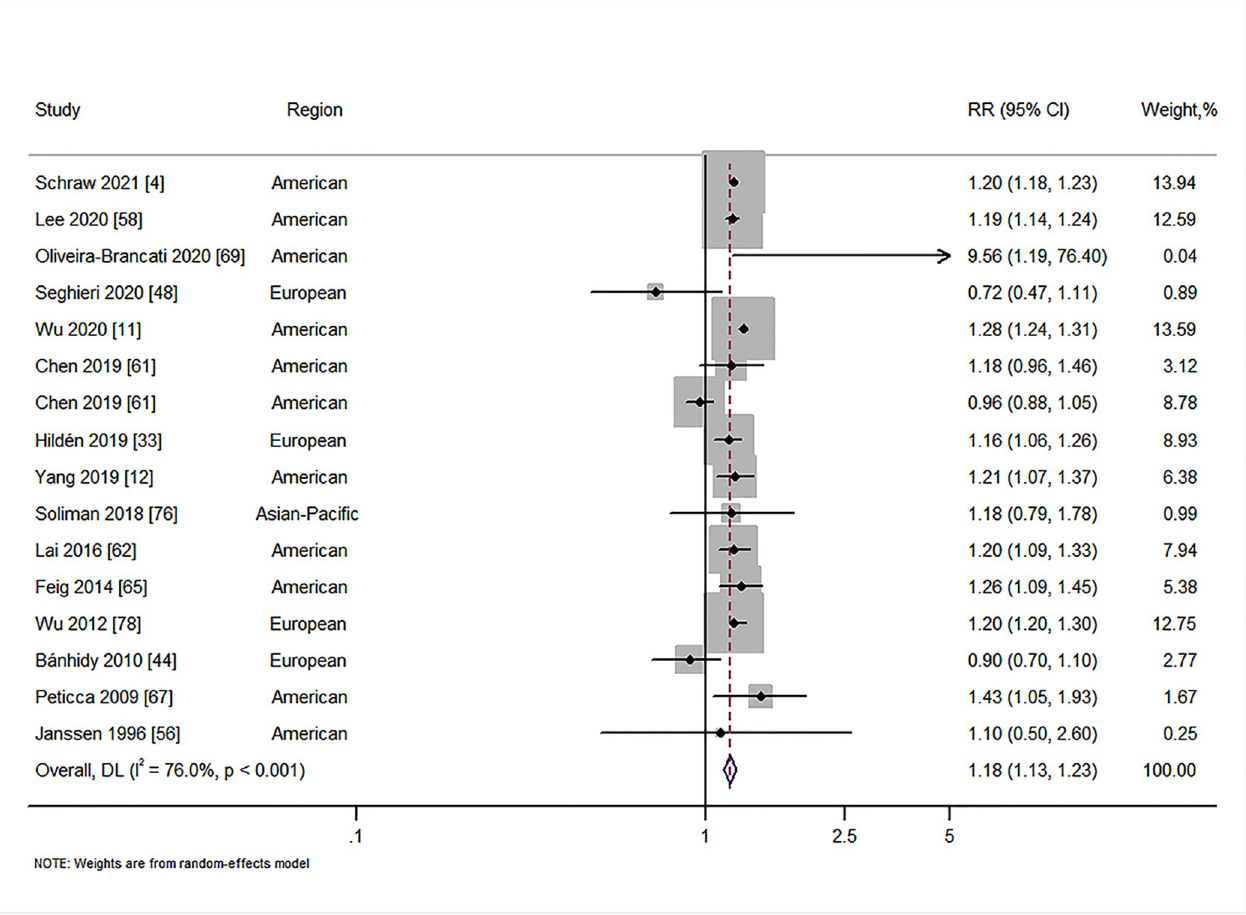
Fig 3. Forest plot of the RRs in population-based studies formaternal gestational diabetes and the risk of overall congenital anomalies (RR = 1.18, 95% CI 1.13 to 1.23, I 2 = 76.0%, P < 0.001). Analytical weights are from random effects meta-analysis. Grey boxes represent study estimates; their size is proportional to the respective analytical weight. Lines through the boxes represent the 95% CIs around the study estimates. The diamond represents the mean estimate and its 95% CI. The vertical red dashed line indicates the mean estimate. CI, confidence interval; DL, DerSimonian and Laird random effects model; RR, relative